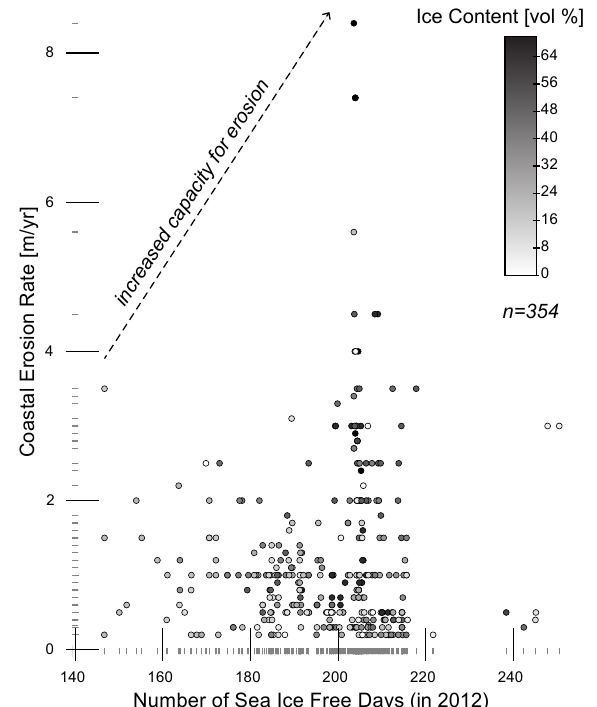
Figure 6. Comparison of coastal-erosion rate and ice content from the Arctic Coastal Dynamics database (Lantuit et al., 2012) and the number of open-water days for 2012 (same analysis as in Fig. 1). For visual clarity, only points with erosion rates greater than 0.1myr − 1 are plotted. Gray tick marks on x and y axes indicate the distribution of values. The relationship between open-water days, erosion rate, and ice content is not simple. Up until ∼ 220 open- water days, the longer the open-water season, and the higher the ice content, the greater the capacity for high coastal-erosion